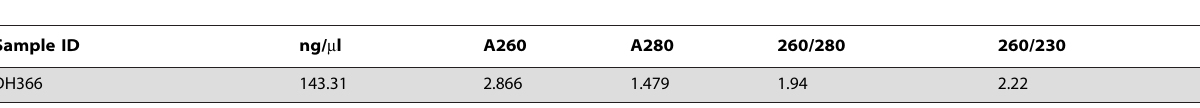
Table 1. Evaluation of DNA quality using a NanoDrop 1000.